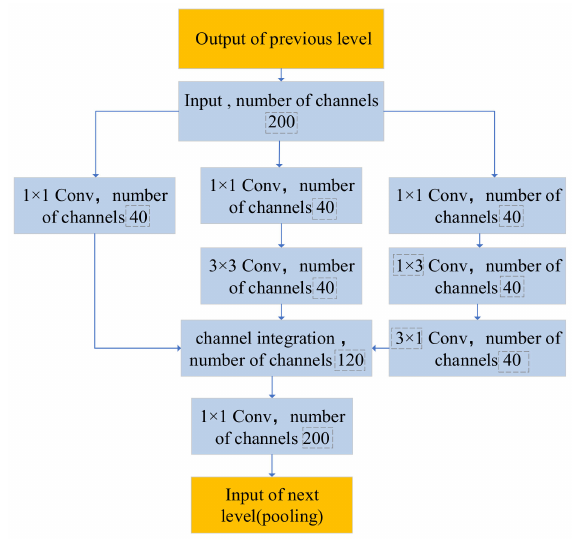
Figure 8. Inception 2